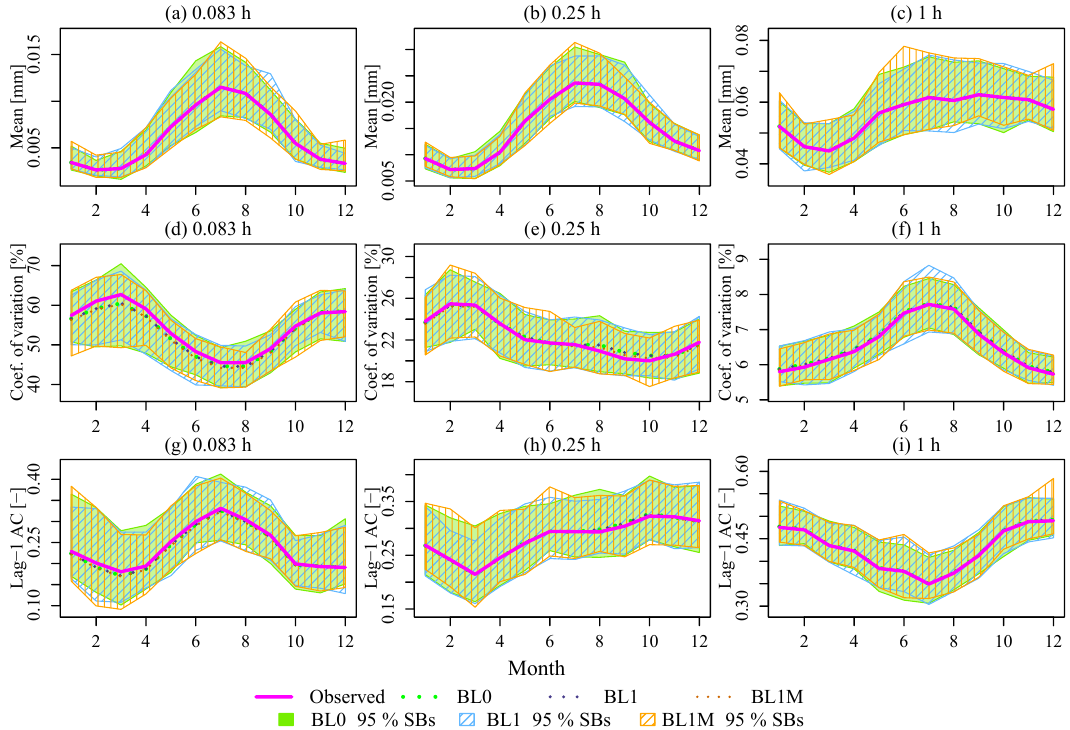
Figure 8. Seasonal variation in mean, coefficient of variation, and lag-1 autocorrelation for selected censors at Atherstone, observed vs. estimated.